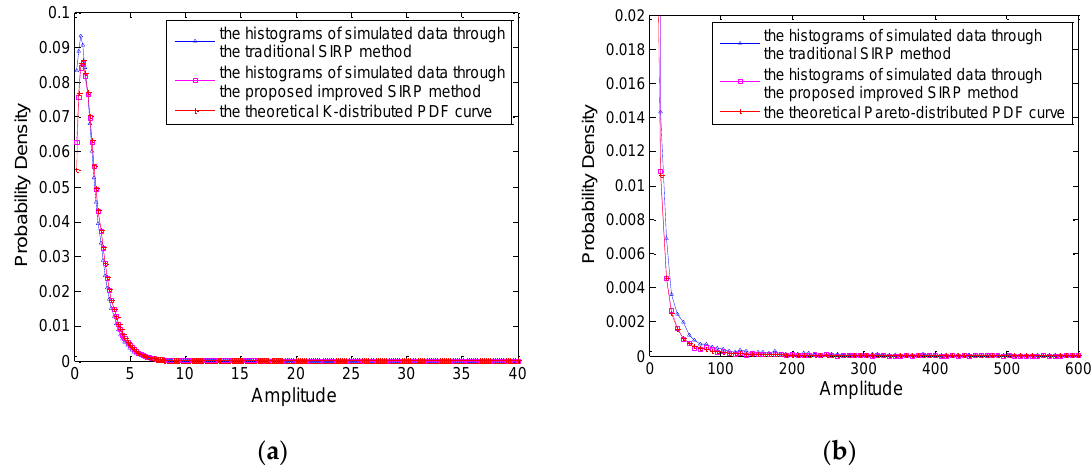
Figure 7. Theoretical PDF and averaged histogram of the simulated data generated by the traditional SIRP and the proposed improved SIRP methods. ( a ) K distribution ( b ) Pareto distribution.